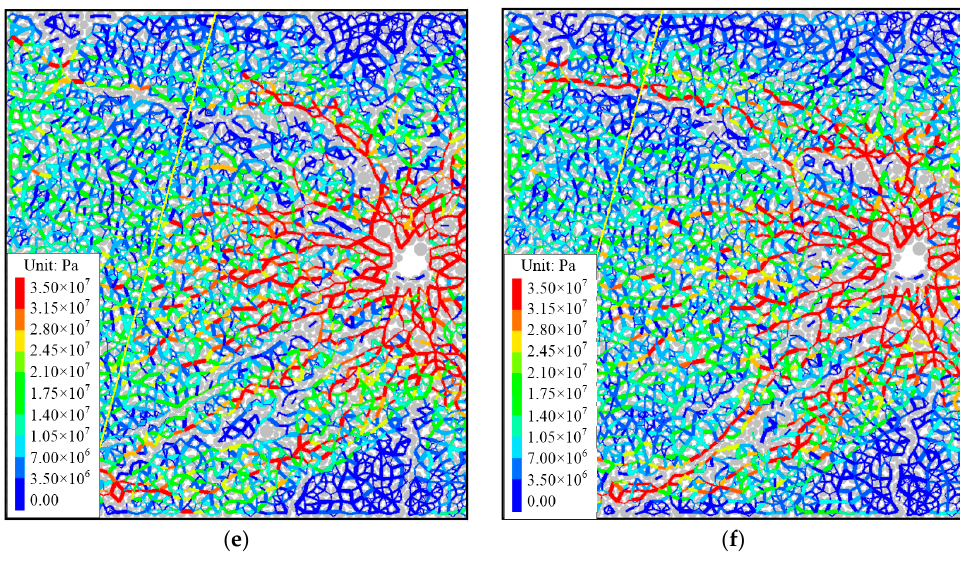
Figure 15. Distribution of injection pressure with variation of the distance between the injection hole and the fault: ( a ) L if = 10 m; ( b ) L if = 20 m; ( c ) L if = 30 m; ( d ) L if = 40 m; ( e ) L if = 50 m; and ( f ) L if = 60 m.